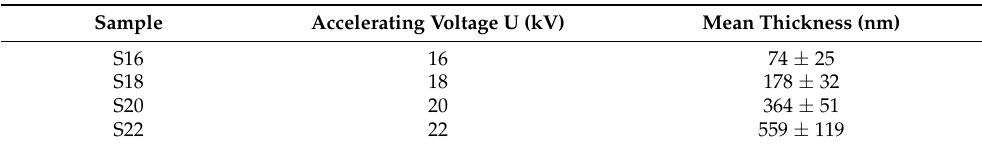
Table 1. Mean thickness of the sample layers as obtained from CM measurements; values determined as the average of four measurements taken at different locations on the tested